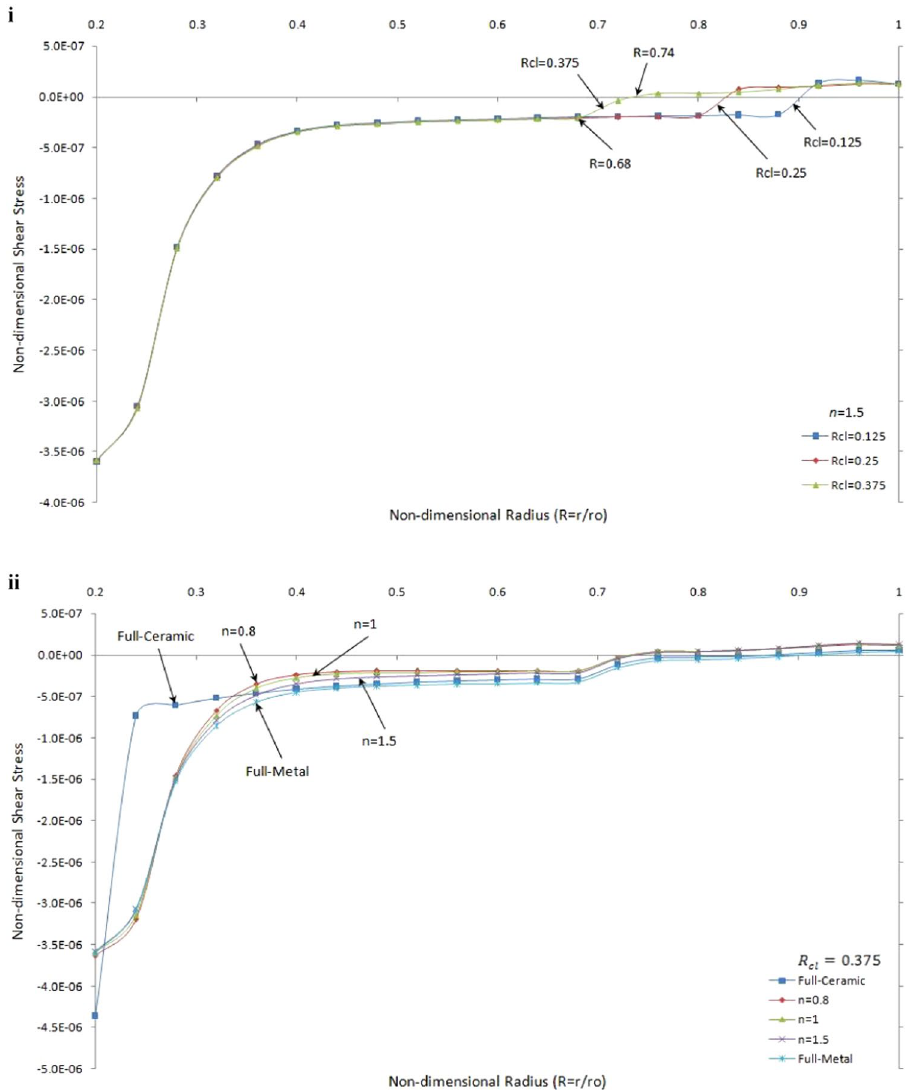
Figure 7. Non-dimensional shear stress versus the non-dimensional radius of one side contact with thermo- mechanical load (i) in the FGMs rotating brake disk with different R cl and n = 1.5 (ii) in the rotating brake disk with R cl = 0.375 and different values of the grading index